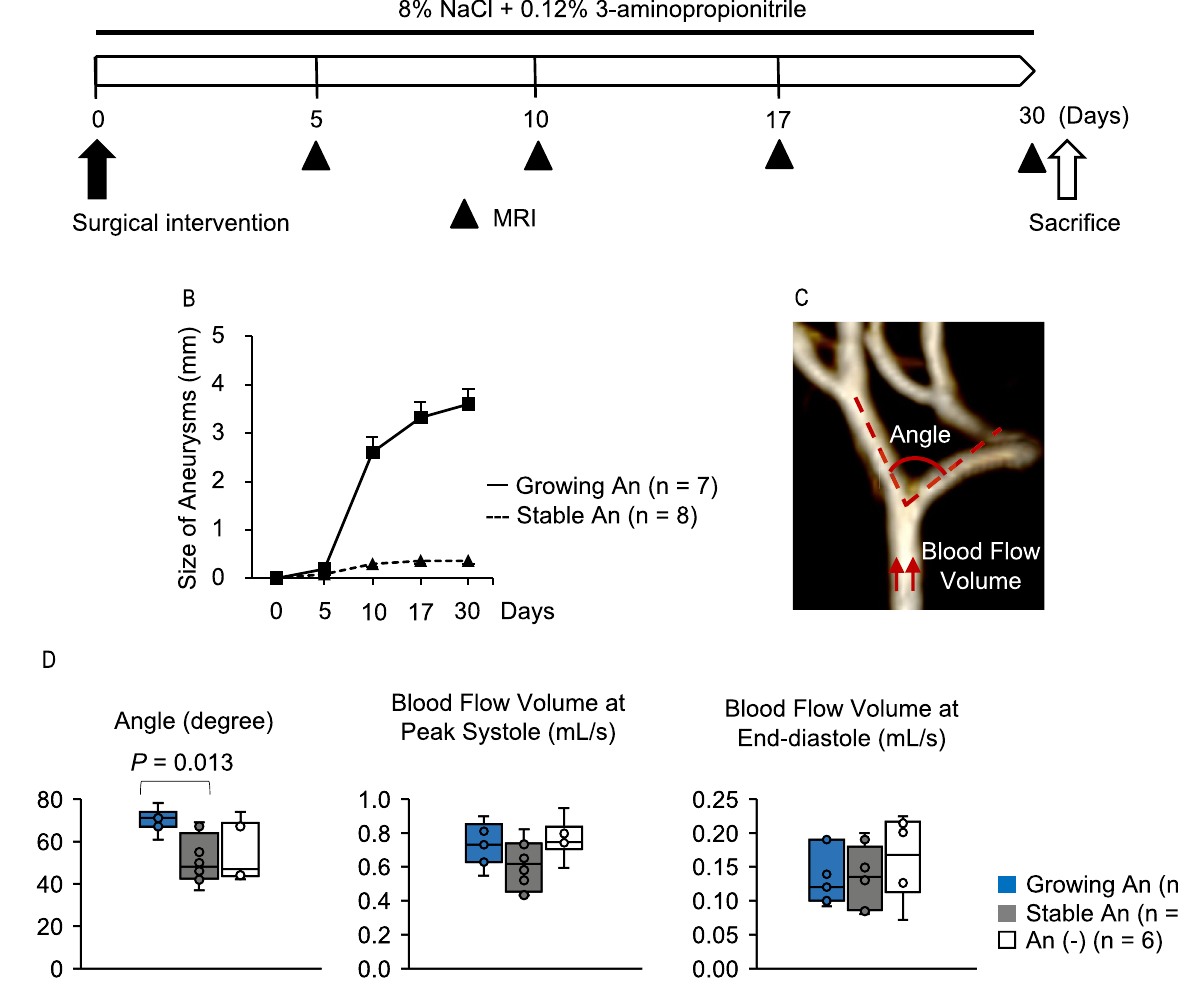
Figure 3. The association of the bifurcation angle with aneurysm progression in rats. ( A ) A schematic representation of the study design. Magnetic resonance imaging (MRI) includes MR angiography and cardiac- gated two-dimensional phase-contrast MRI. ( B ) Sequential assessments by MR angiography showing the size of growing (n = 7) and stable (n = 8) aneurysms (An). Data are presented as means ± SD. ( C ) MR angiography showing the bifurcation angle and the point where blood flow volume estimated by phase-contrast MR imaging was measured. This image was created using Horos visualization software (64-bit, version 3.6.6, https:// horos proje ct. org). ( D ) Comparison of the bifurcation angle (the left panel) and blood flow volume at peak systole (the middle panel) and end-diastole (the right panel) between growing (n = 7), stable (n = 8), and no An (n = 6) on